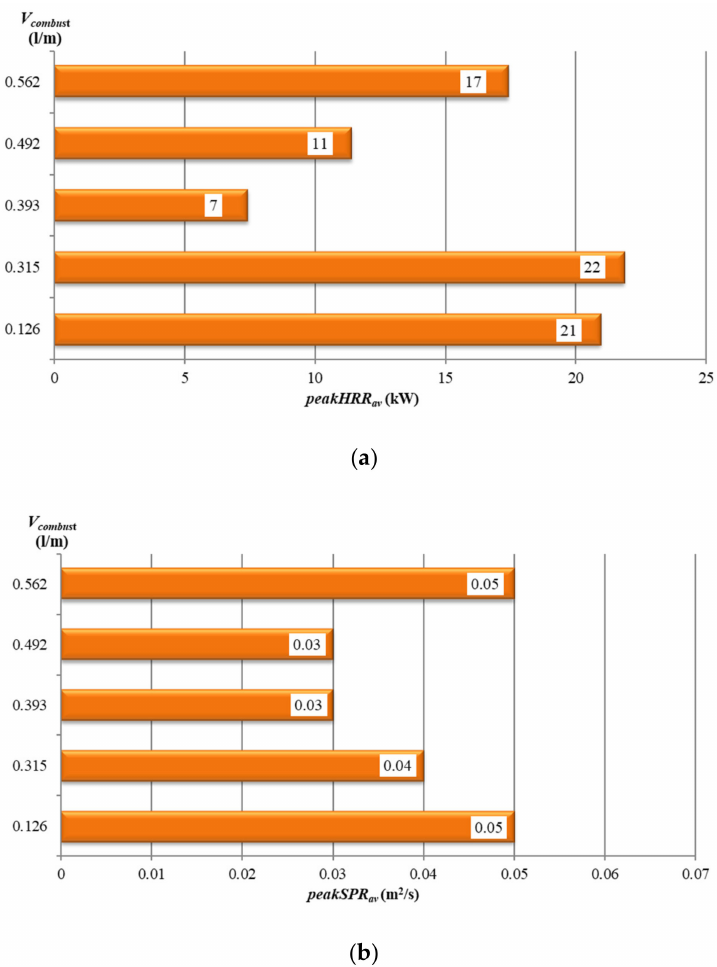
Figure 10. Tested cables vs. their non-metallic volume Vcombust: ( a ) peakHRR av ; ( b ) peakSPR av